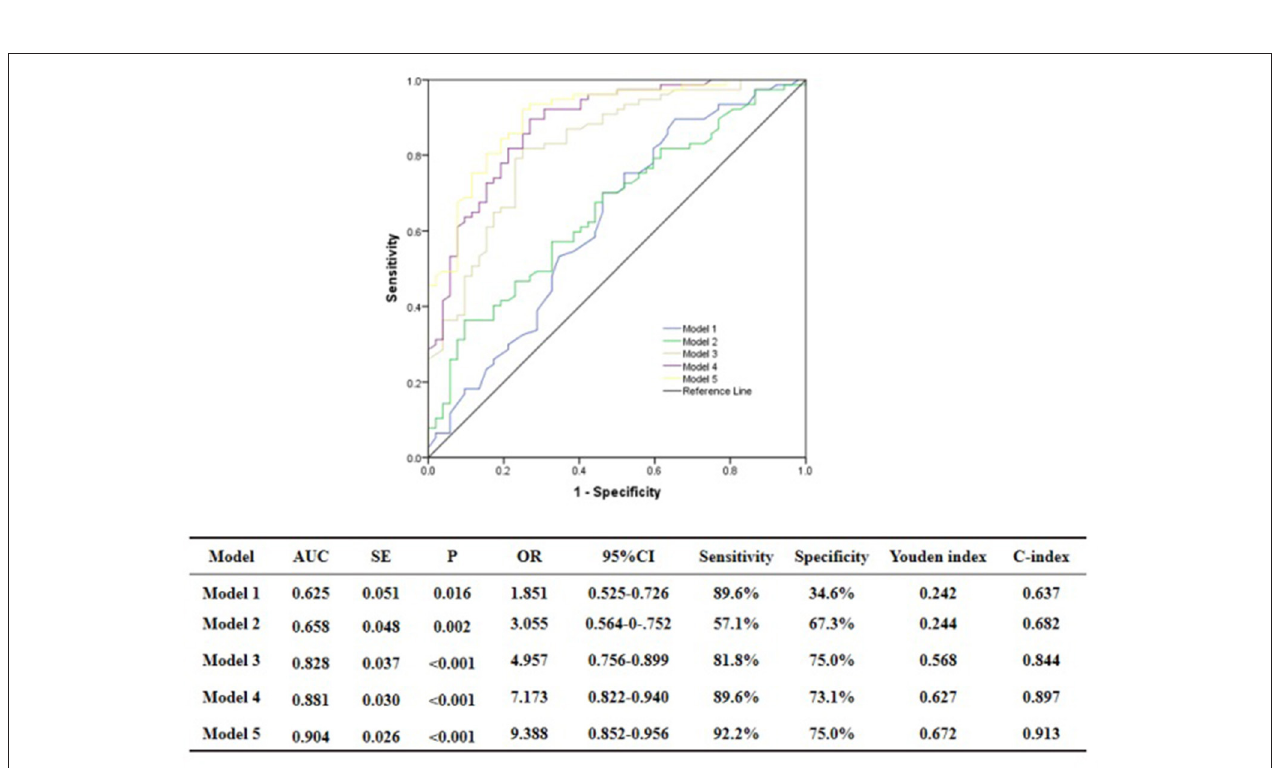
FIGURE 6 | Comparison of discrimination and reclassification abilities of predictive models for functional ischemia of target vessel as detected by cQFR. Model 1, Age + Sex; Model 2, Model 1 + Hypertension + Diabetes mellitus + Current smoking + Current drinking + BMI > 28 Kg/m 2 ; Model 3, Model 2 + Genisi Score > 17; Model 4, Model 3 + hs-CRP > 1.45 mg/L; Model 5, Model 4 + LF > 390.5 ms 2 .